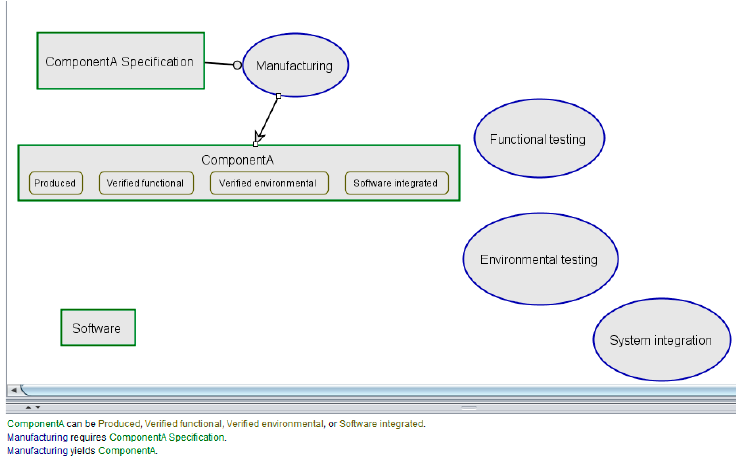
Figure 2. Linking objects and process, option #1.